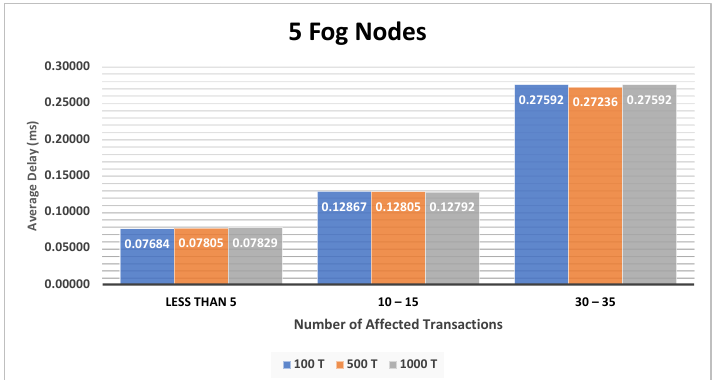
Figure 7. The impact of different number of transactions on five fog